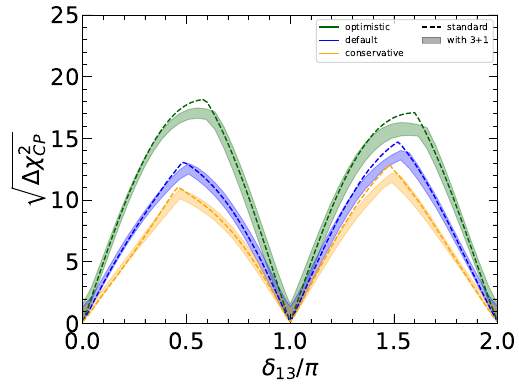
Figure 9 . The impact new mixing parameters due to a light sterile neutrino could have on the determination of CP violation at ESS ν SB for different choices of systematic uncertainties. The width of the bands is due to the variation of δ 14 in the fake data. The dashed lines are the standard sensitivities obtained in section